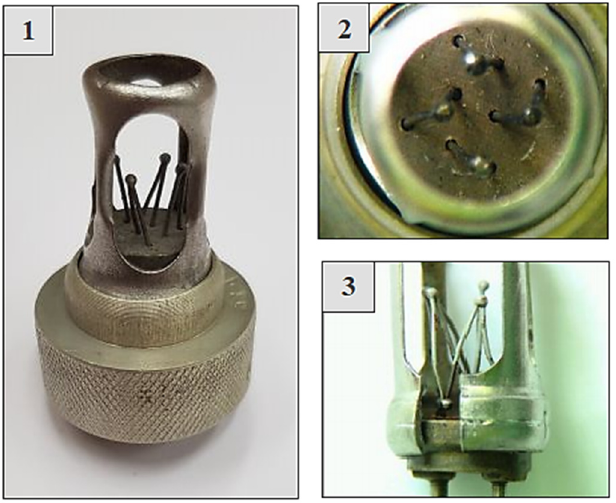
Figure 2. View of uncovered joints—1,2 and covered joints—3 of the DPS